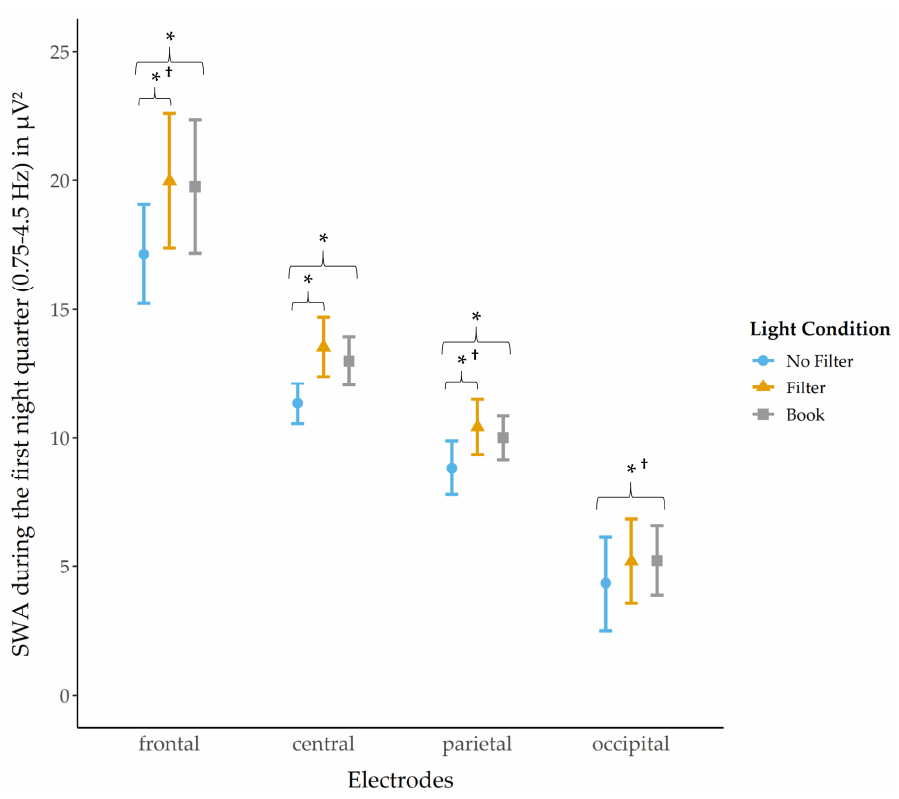
Figure 6. SWA in the first night quarter (mean and 95% confidence intervals). SWA was significantly reduced in the “no filter” compared to the “book” condition at frontal, central, parietal and occipital electrodes. Additionally, SWA was significantly reduced in the “no filter” compared to the “filter” condition at frontal, central and parietal derivations. *: p ≤ 0.05; †: p adj . >